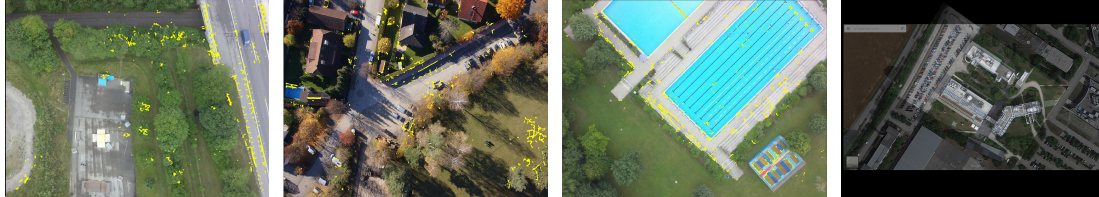
Figure 11. Qualitative results of the proposed matching method according to the image pairs in Figure 2. The first row shows the overlapped UAV and aerial image pairs after applying an estimated homography calculated from our matches (also for the figure on the bottom right). The second and third row show the distribution of the geometrically-correct matches in the UAV images (yellow